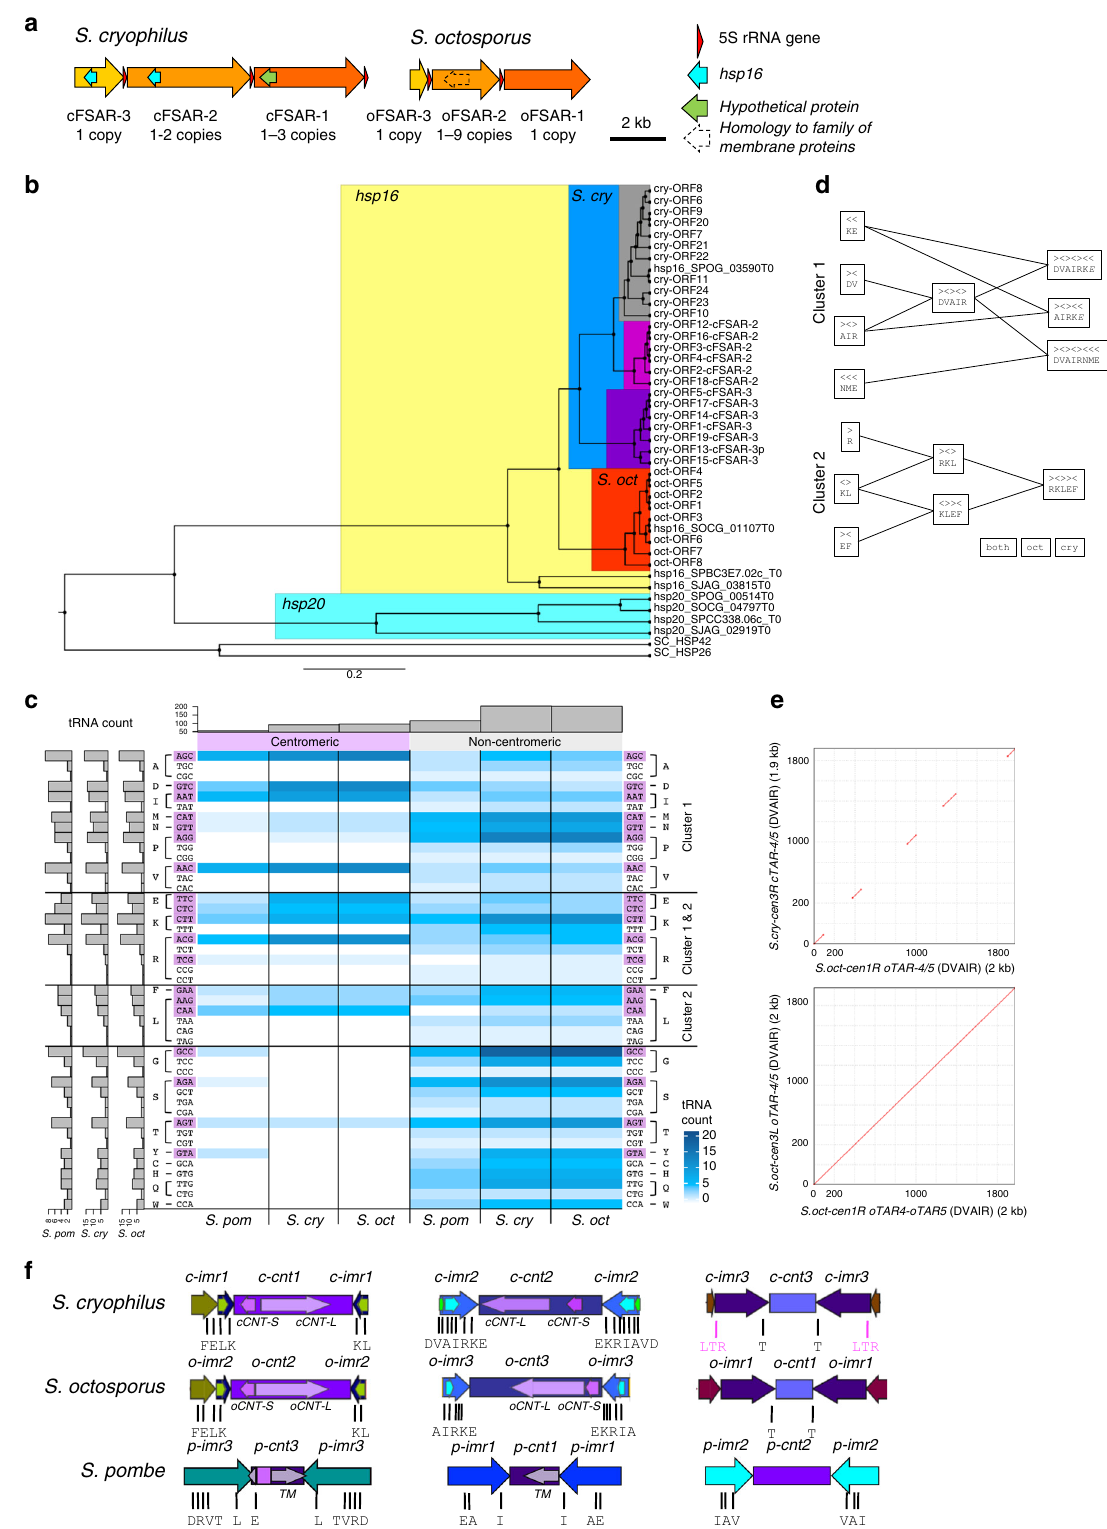
intrinsic CENP-A deposition programme conserved between Schizosaccharomyces centromeric DNA. Based on conserved features, ancestral Schizosaccharomyces centromeres may have consisted of a CENP-A Cnp1 -assembled central-core surrounded by tRNA gene clusters and 5S